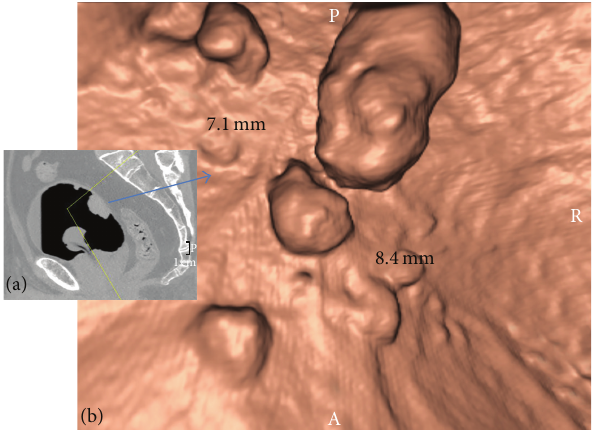
Figure 3: Multifocal exophytic lesions on the anterior and posterior wall of the bladder. (a) MDCT image (sagittal plane) and (b) VC image (after 3D reconstruction). The pathology report revealed a pT1 TCC of the